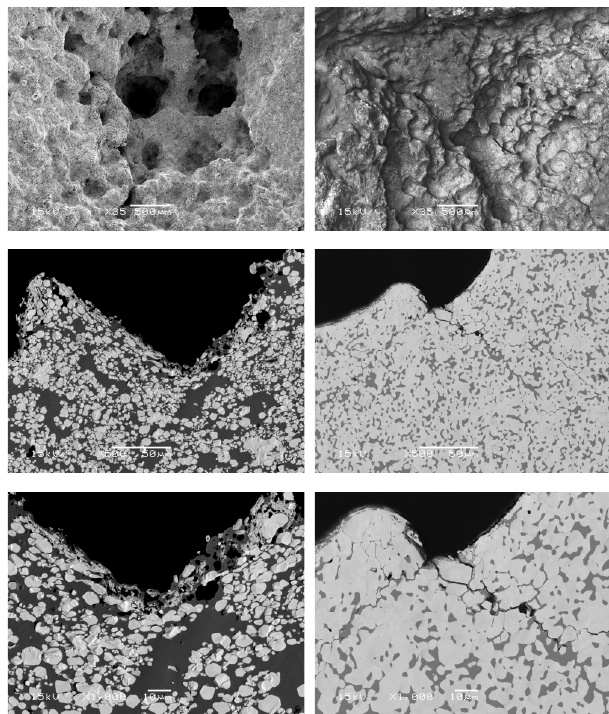
FIG. 8. Backscattered electron micrograph for CW70E (left) after 67 shots at 6.1-MV and for 50W3 (right) after 106 shots at 6.1-MV. The top picture for each material is a top surface view of an arc region. The middle and bottom pictures are cross sections of the bulk material through an arced region at two different scale